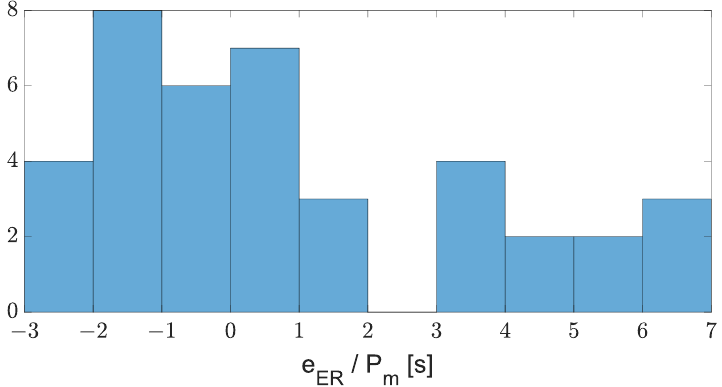
Figure 14. Comparison between the measurement of the energy required to complete the mission from a waypoint and the estimation obtained with the developed system.